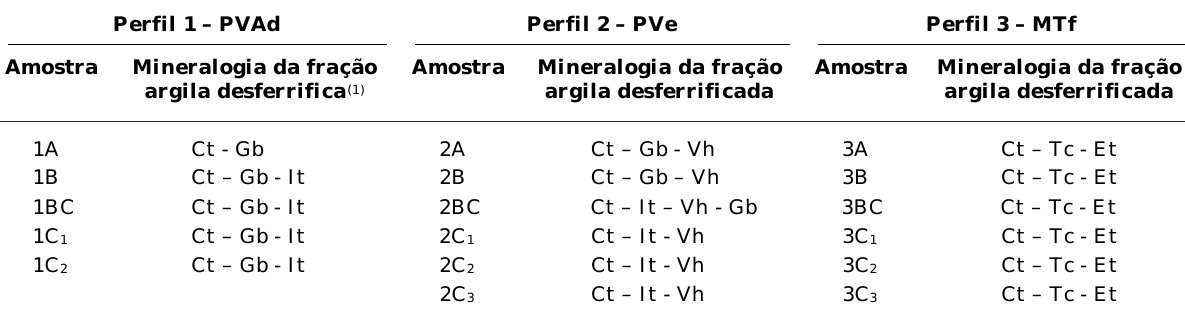
(1) Ct = caulinita, Gb = gibbsita, Vh = vermiculita com hidróxi nas entrecamadas, It = illita, Tc = talco e Et =